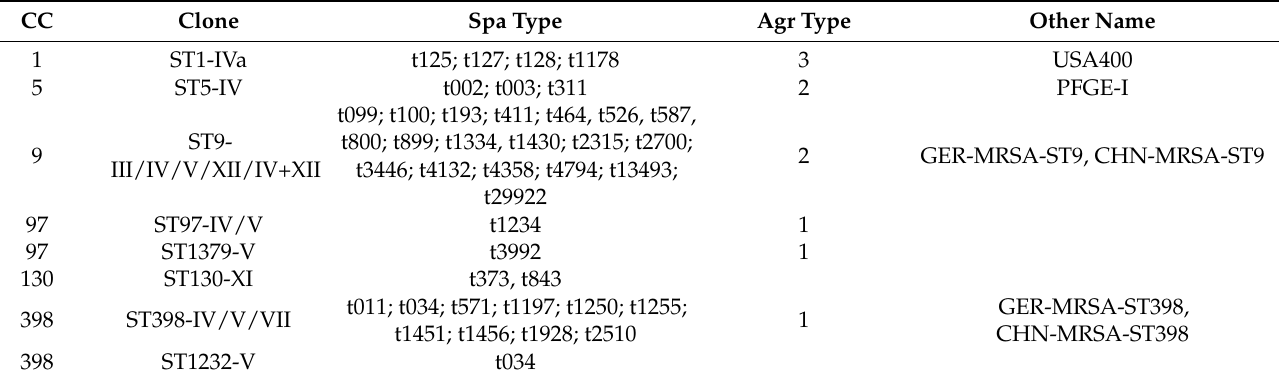
Table 6. LA-MRSA